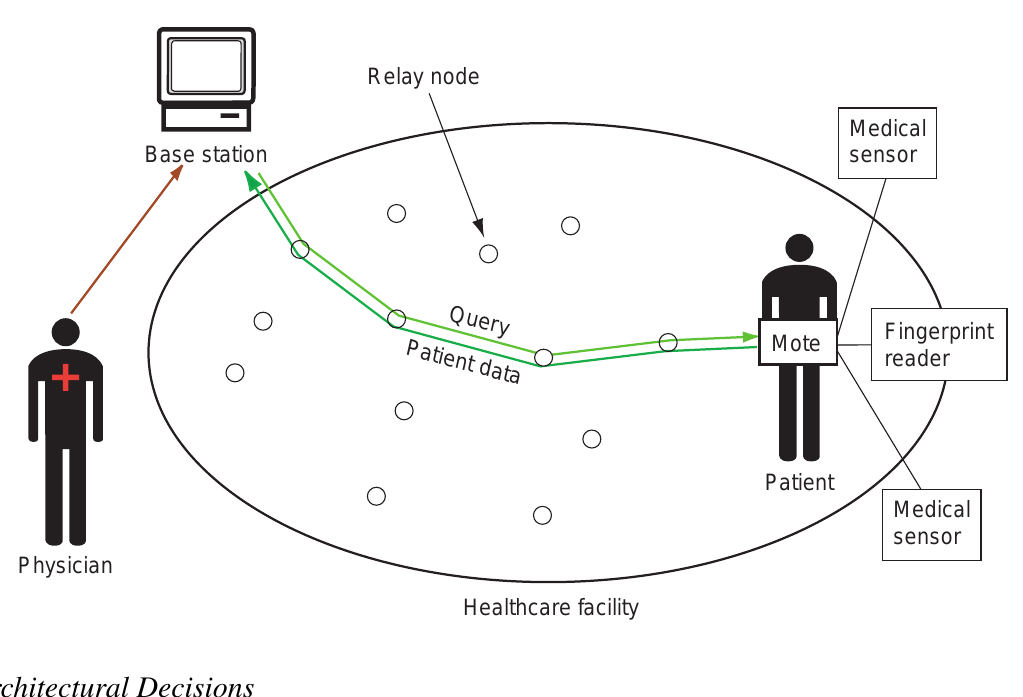
Figure 1. Wireless health monitoring